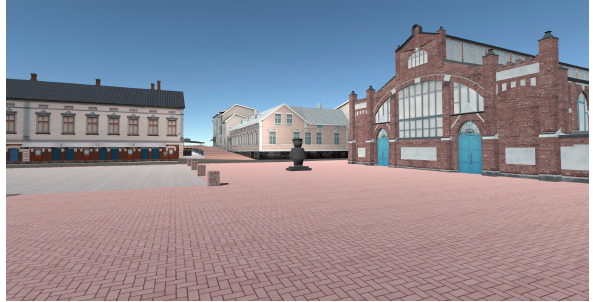
Figure 3. VirtualOulu is a web-based collaborative 3D environment depicting the center of Oulu [62].